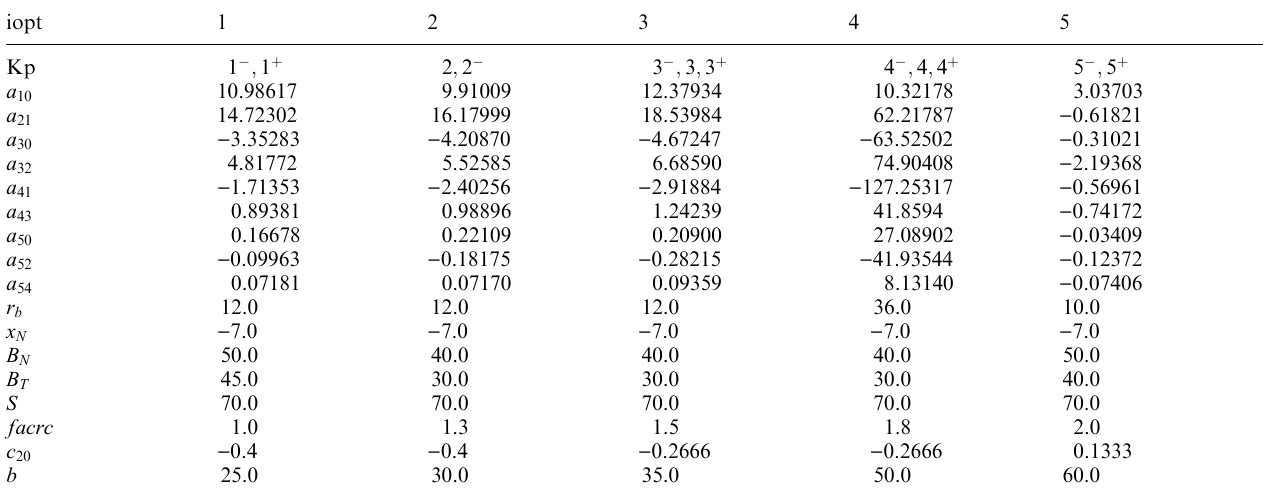
Table 1. Various coe(cid:129)cients and their Kp relationships